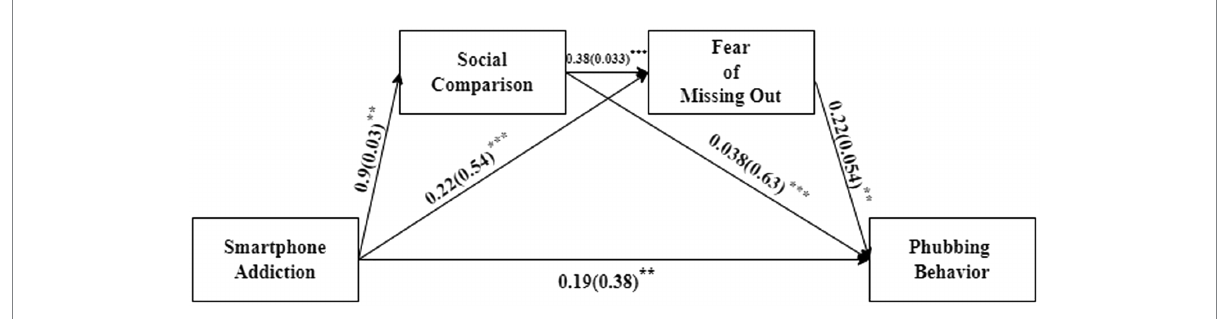
FIGURE 3 Model of multiple mediations. The path coefficients are the path values (standard errors). *** p < 0.001, ** p <